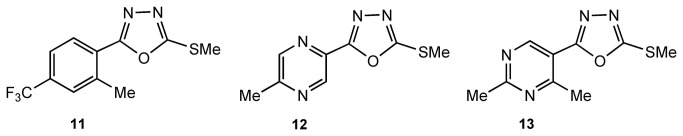
Compounds 11-13.